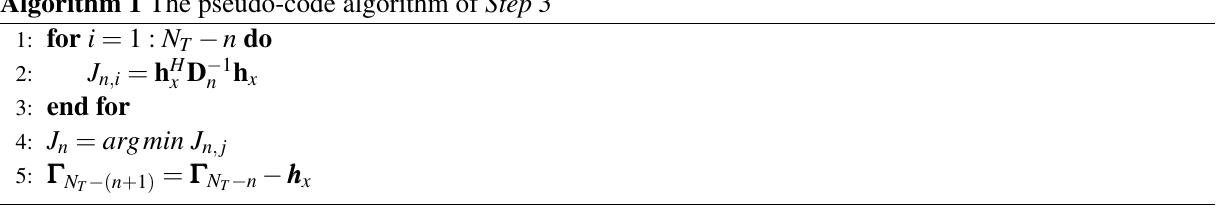
Algorithm 1 The pseudo-code algorithm of Step